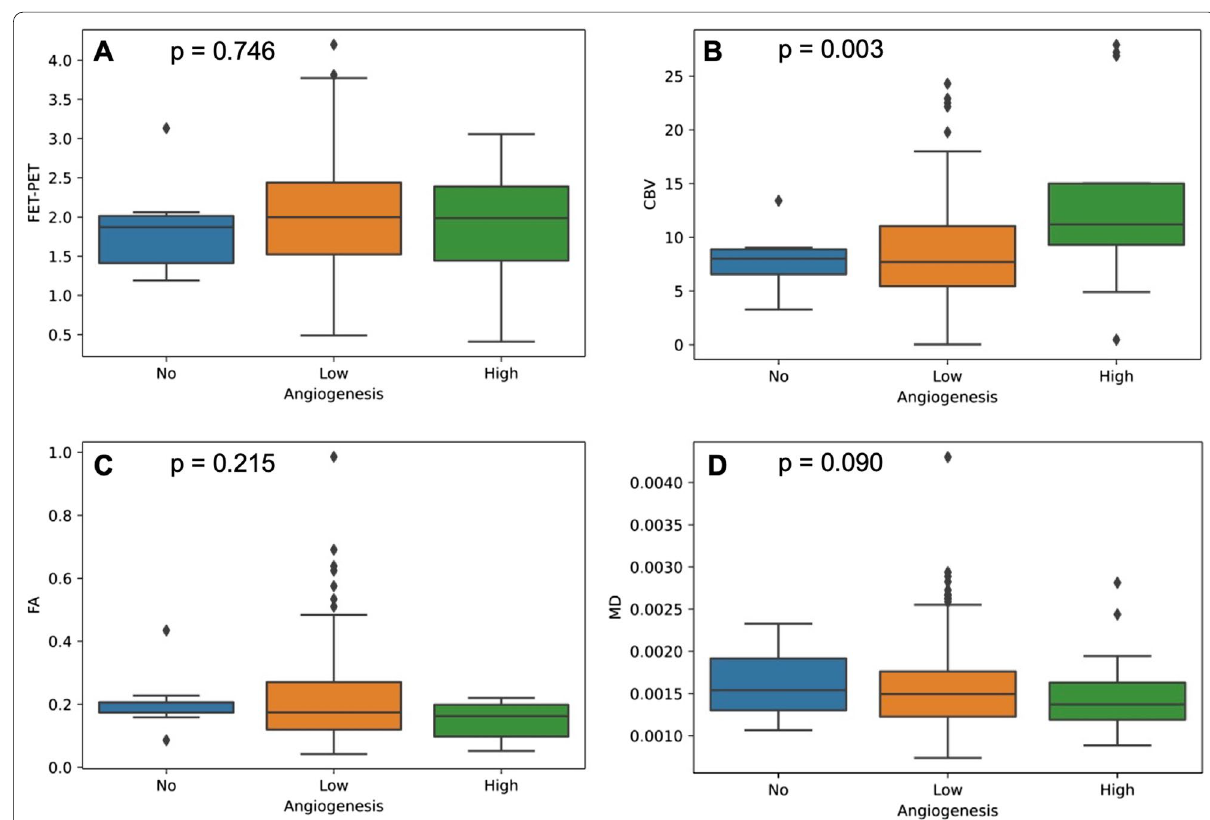
Fig. 1 Imaging parameters and neovascularization. Boxplots show median [18F] FET PET ( a ), CBV ( b ), FA ( c ) and MD ( d ) signal in biopsies without (blue), with low (orange), or high (green)